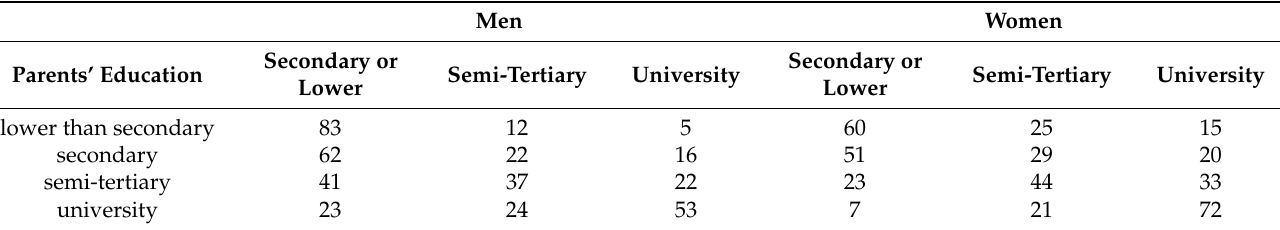
Table 3. Educational mobility table, birth cohorts